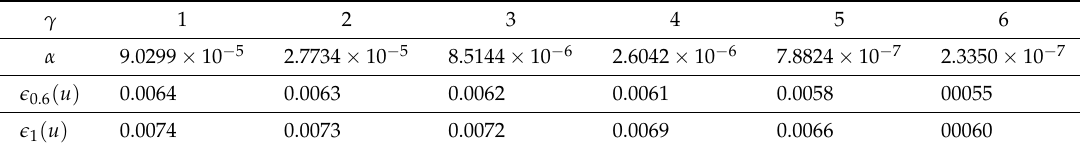
Table 4. k = 1.5, ε = 0.01, the relative root mean square errors for various γ at y =